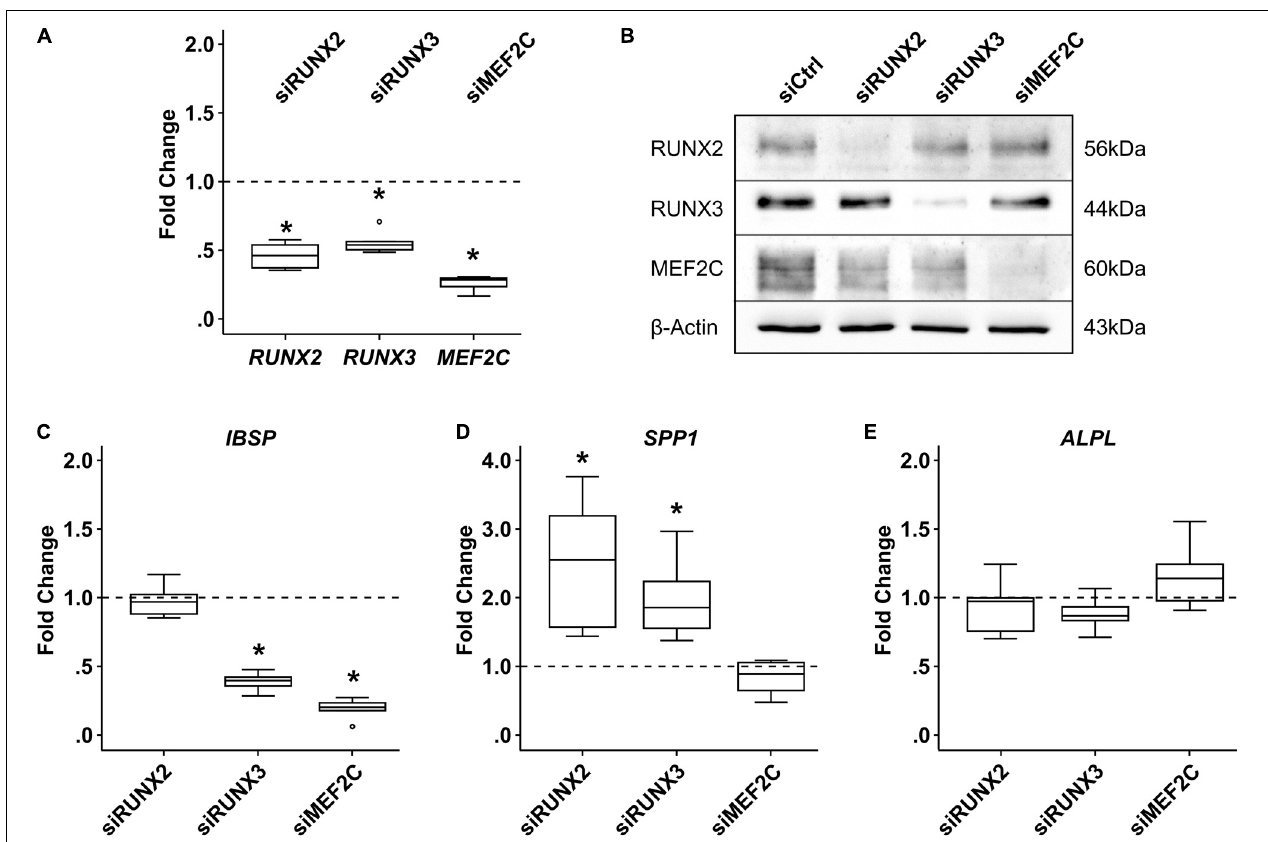
FIGURE 10 | Effects of siRNA-mediated knockdown of MEF2C, RUNX2, and RUNX3 in SAOS-2 osteosarcoma cells. SAOS-2 cells were transfected with siMEF2C, siRUNX2, siRUNX3, or a non-targeting control siRNA (siCtrl) 48 h prior to analysis ( n = 6 biological replicates from four independent experiments). (A) Target-gene expression was determined by qPCR. (B) MEF2C, RUNX2, and RUNX3 protein levels were determined by Western blot analysis; β -actin levels were determined as internal reference. One representative of four biological replicates (two to three experiments) is shown. Expression of indicated genes was determined by qPCR (C–E) , and levels were referred to reference genes HNRPH1 and CPSF6 . Expression levels of indicated genes are referred to siCtrl cultures (dashed lines). Box plots were generated as described in Figure 1 ; outliers are depicted as ◦ . Significance compared to siCtrl was determined by Mann–Whitney U test *, p ≤ 0.05, with Bonferroni